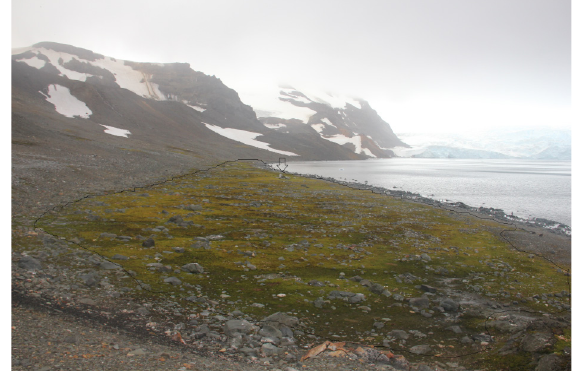
Figure 2. Moss field (black contour) where the whale skeleton was disposed (arrow). The photo was taken in